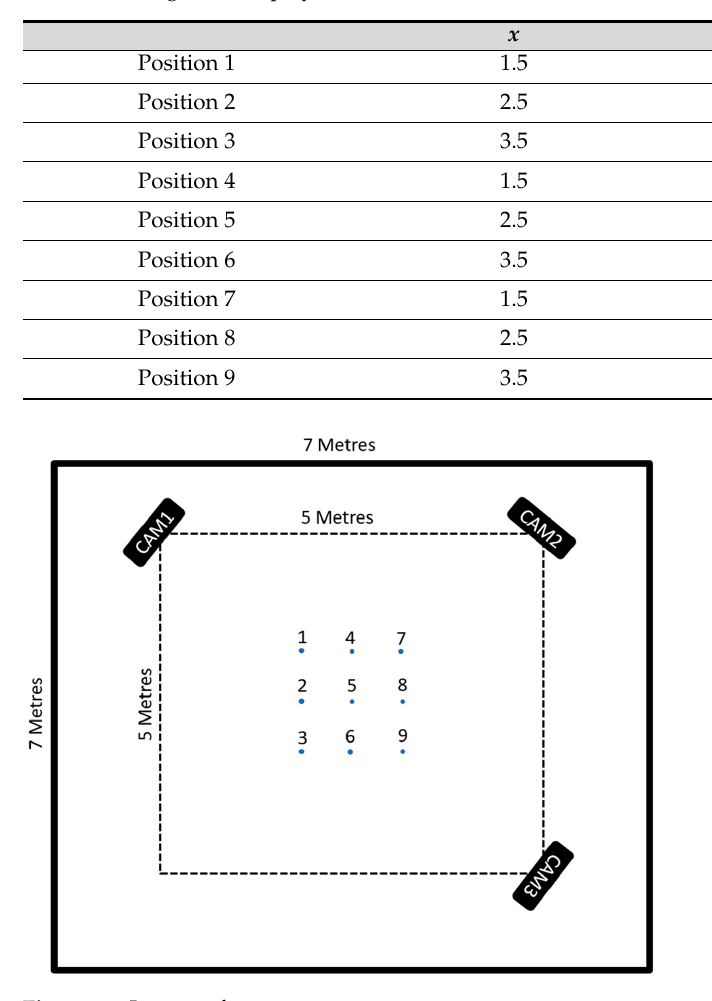
Figure 10. Layout of